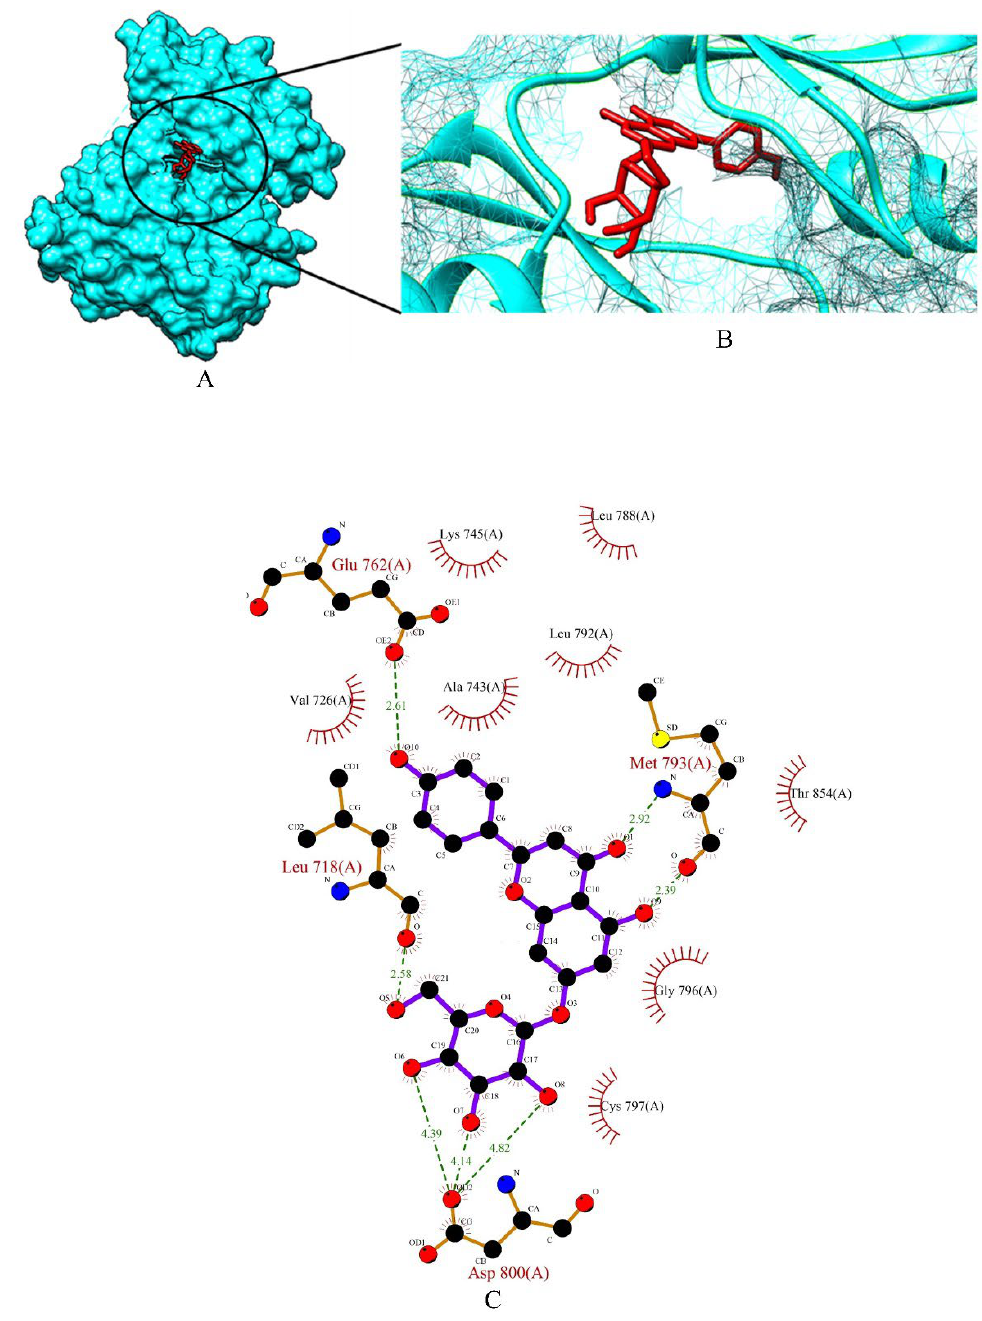
Figure 10. ( A ) Surface view of apigetrin-EGFR binding complex. ( B ) Binding pose of apigetrin. ( C ) Visualization of the docked complex with ligplot + shows the binding interaction of apigetrin with EGFR. Seven hydrogen bond interactions (green dotted lines) were formed between apigetrin and four amino acid residues (Leu 718, Glu 762, Met 793, Asp 800) of target protein EGFR.